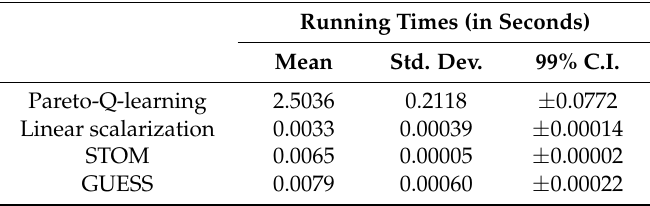
Table 3. Running time